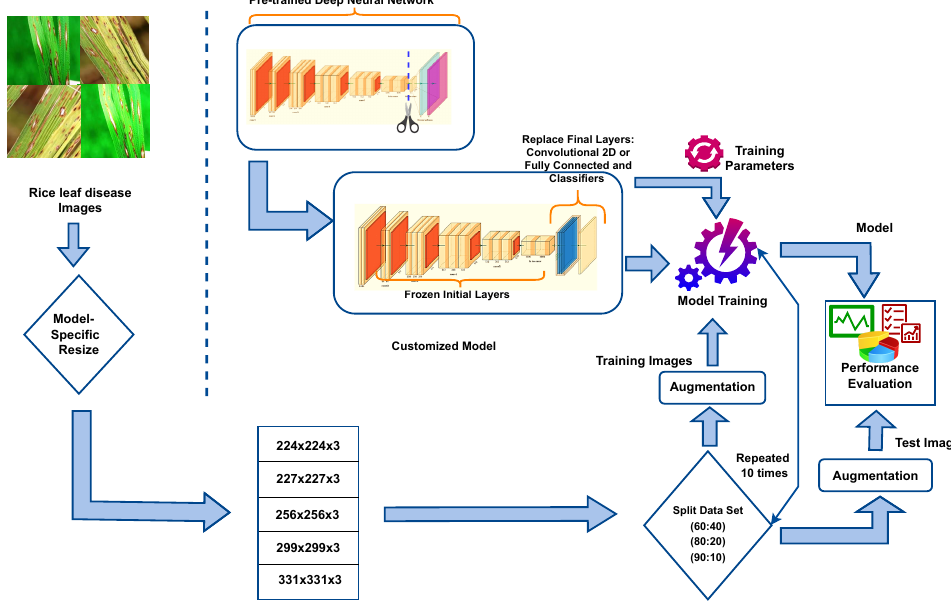
Figure 1. An illustration of the successive stages in the conceptualization of the proposed